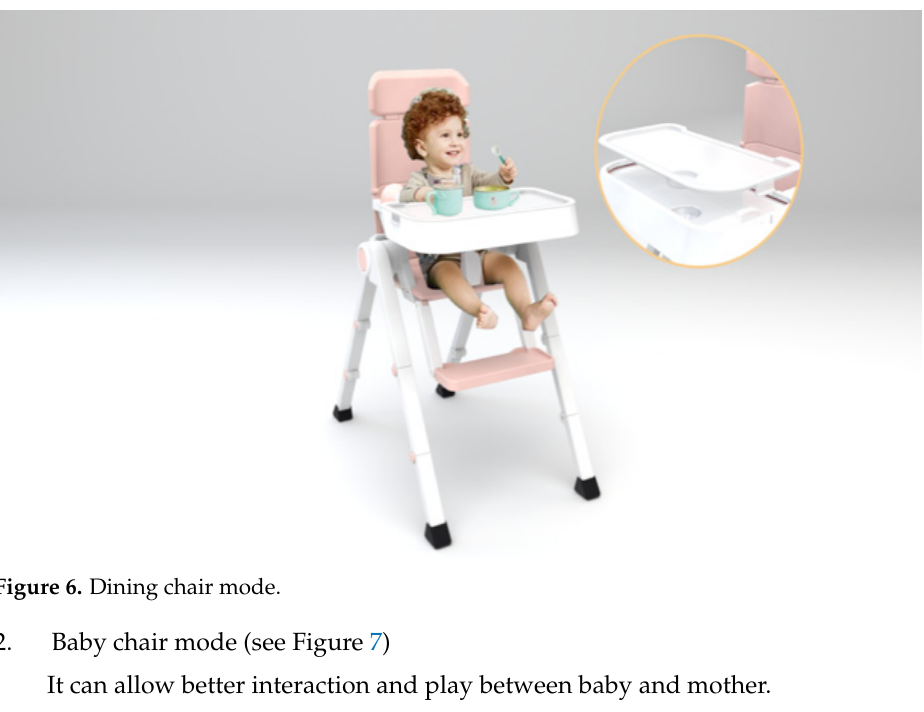
Figure 5. Preliminary draft model with Creo Parametric.